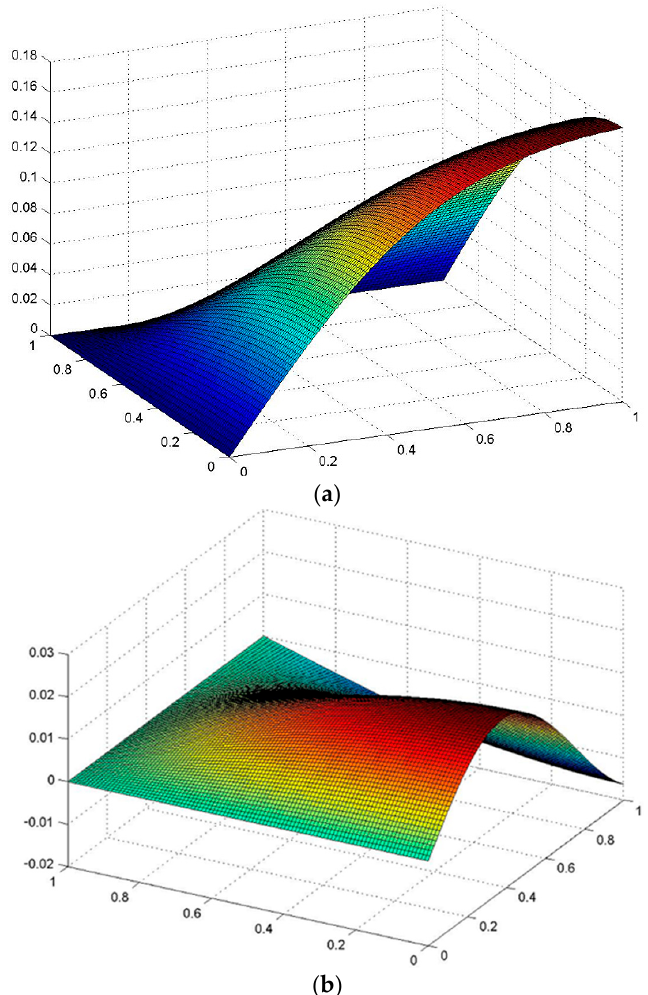
Figure 5. Vibration form of a rectangular plate of variable thickness at t = 180: ( a ) A, A ij = 0; ( b ) A, A ij = 0.05.